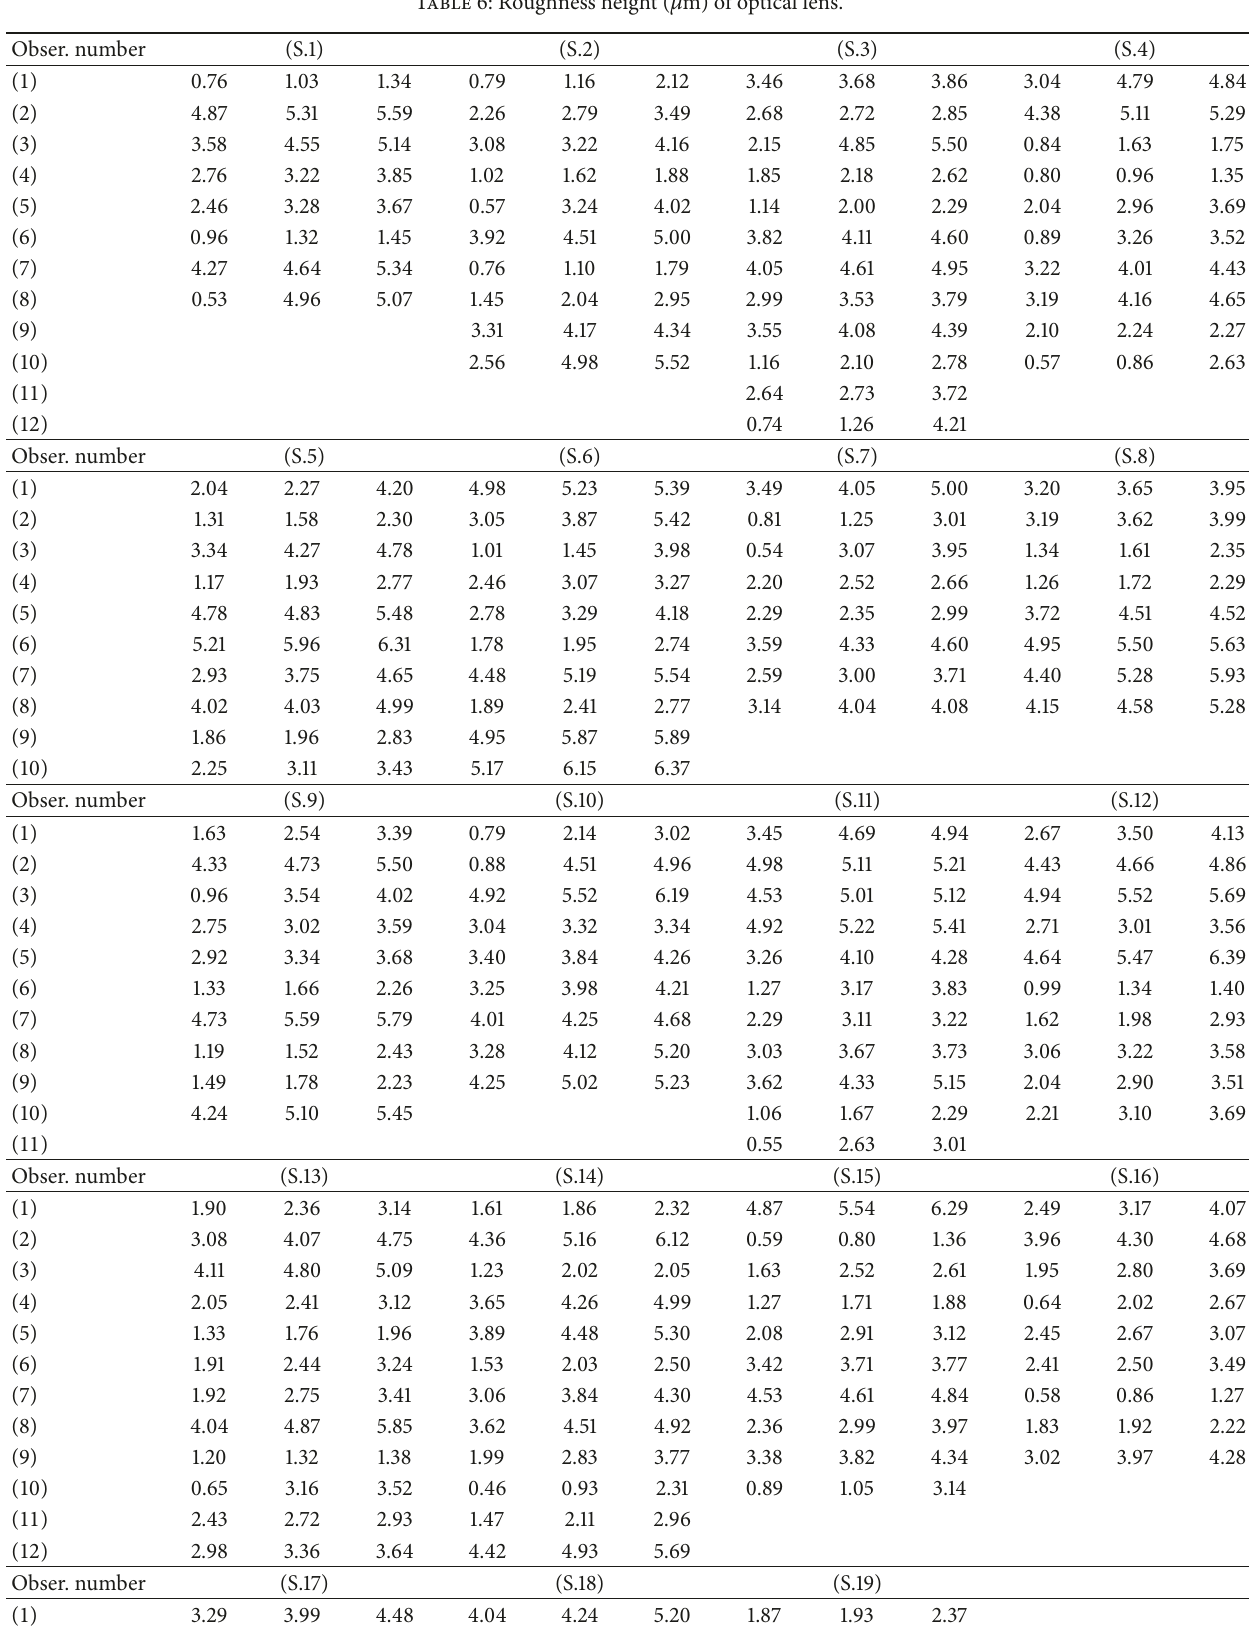
Table 6: Roughness height ( 𝜇 m) of optical